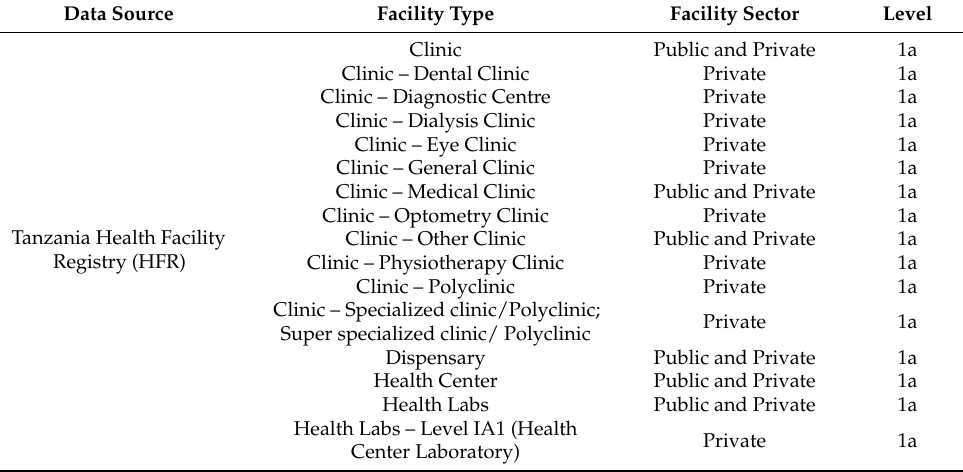
Table 2. Health facility